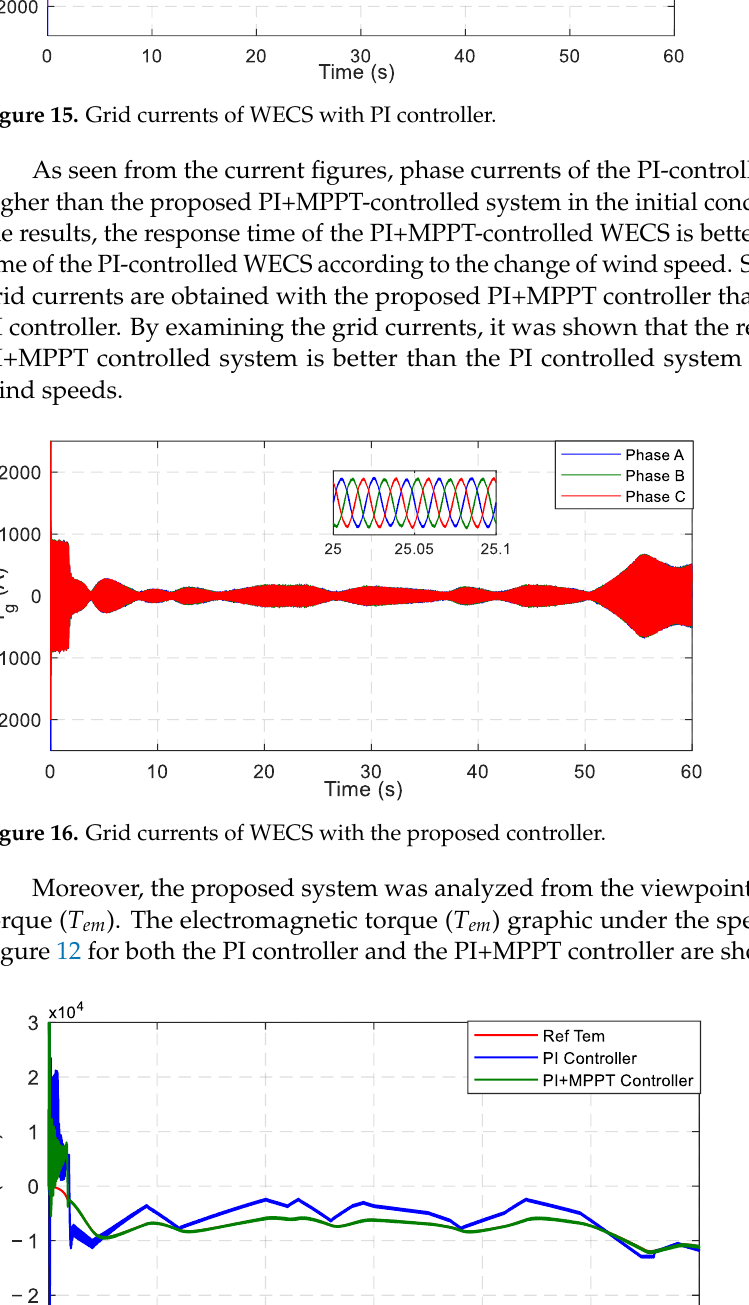
Figure 17. Electromagnetic torque ( T em ) of the DFIG.